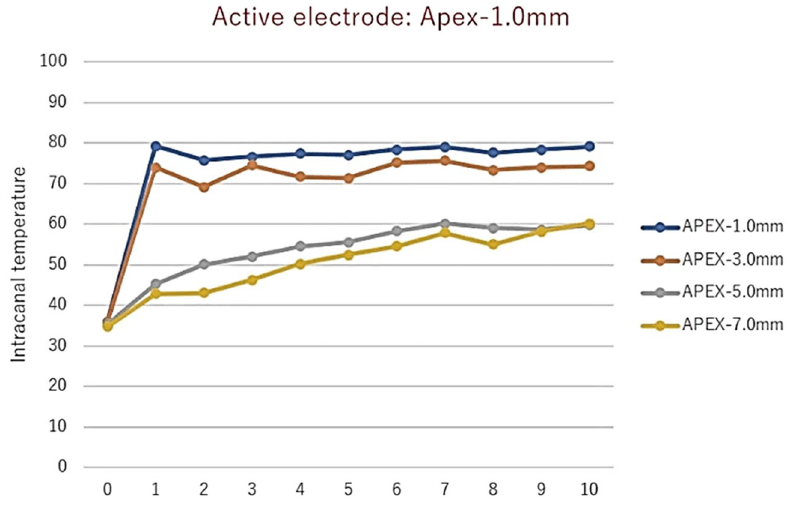
Figure 8. Intracanal temperature rises of mandibular incisors after 1 s EMS activation at various depths from the apex. NOTE: y-axis unit is degrees Celsius; x-axis unit is the number of times EMS activated for 1 s (Courtesy of Dr. Tominaga, International Society for Electromagnetic